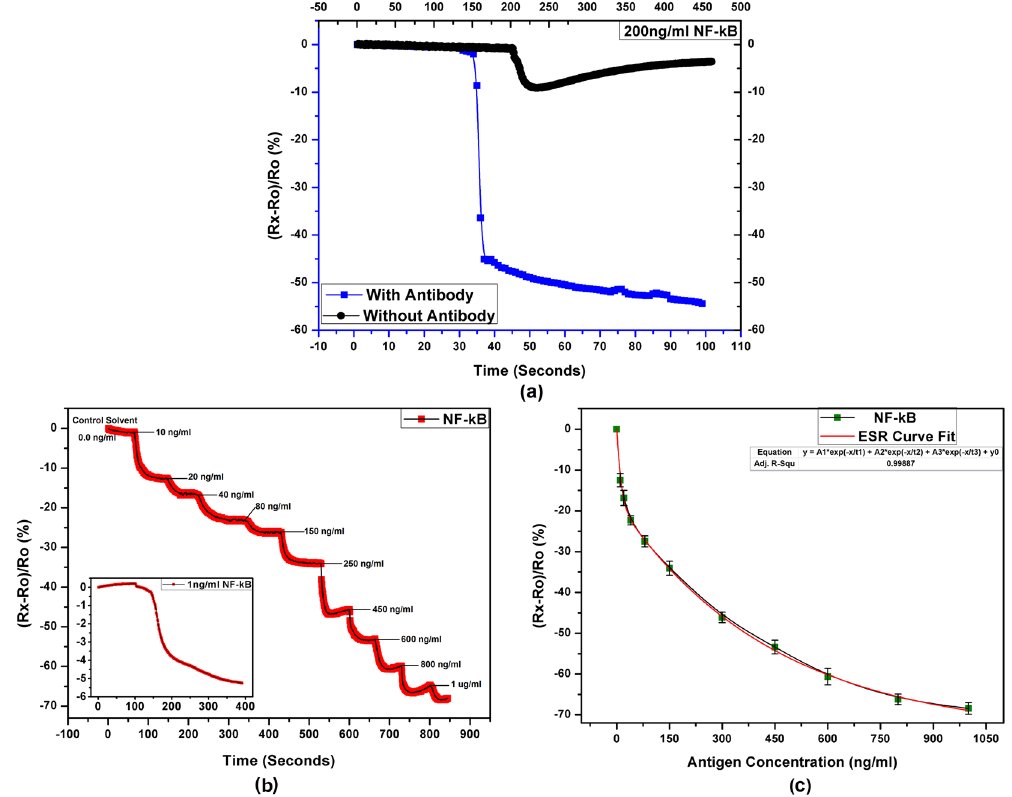
Figure 6. NF- κ B immunosensor response ( a ) addition of 200 ng/ml NF- κ B to sensors with and without immobilized antibodies, ( b ) step response showing stable readings with time for increasing concentrations of NF- κ B with inset showing LoD curve for 1 ng/ml NF- κ B, and ( c ) response curve for the full tested range.